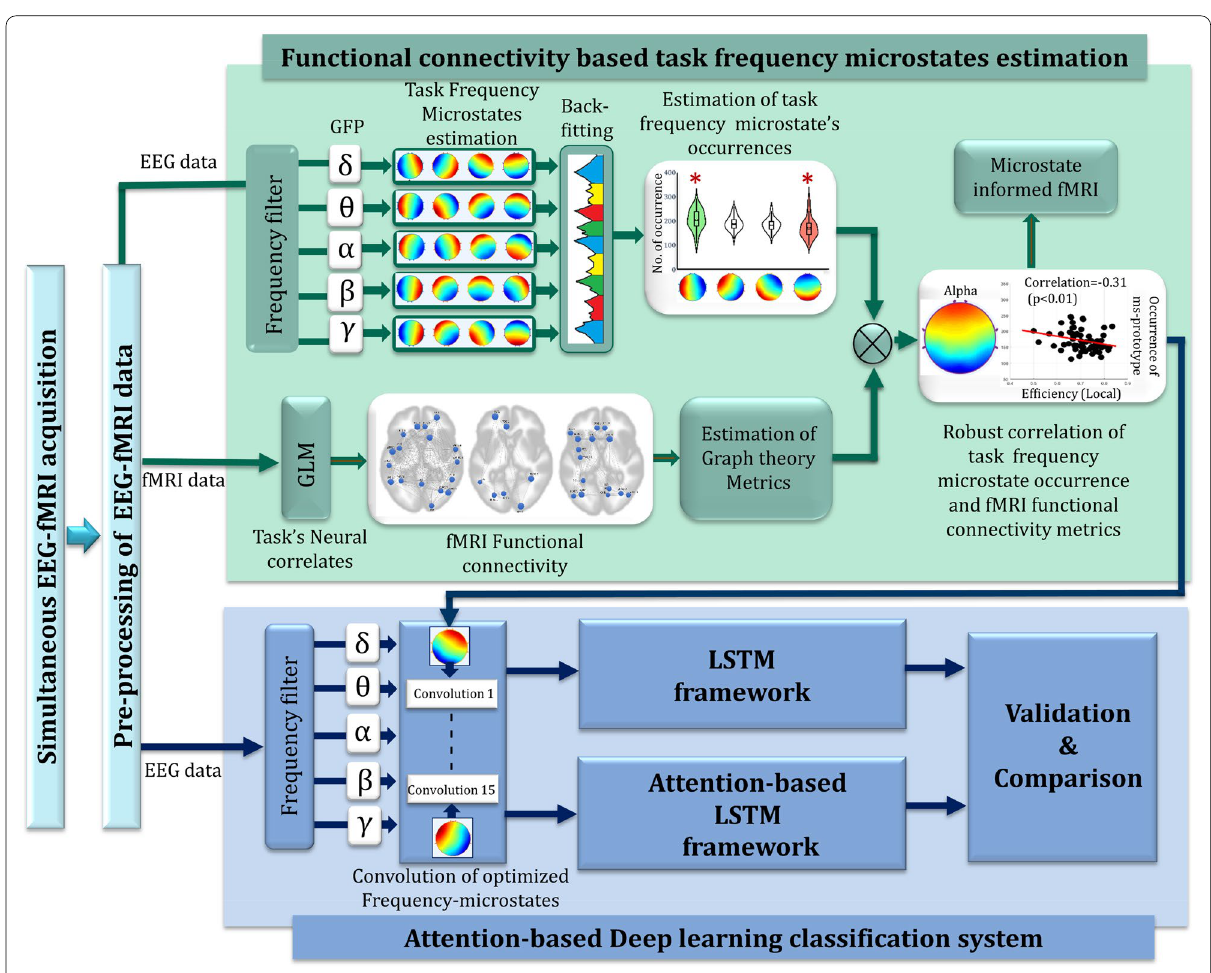
Fig. 2 Methodological framework of the